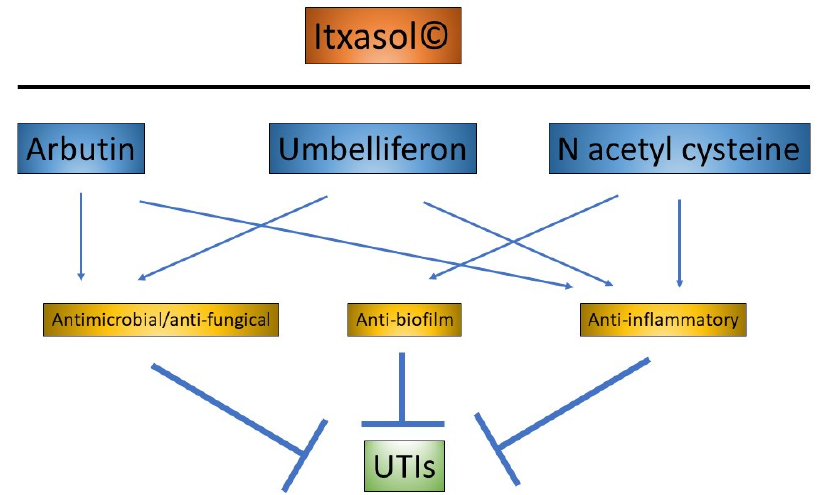
Figure 4. Combined mechanism of action of the three components of Itxasol©: β -arbutin, UMB and NAC.